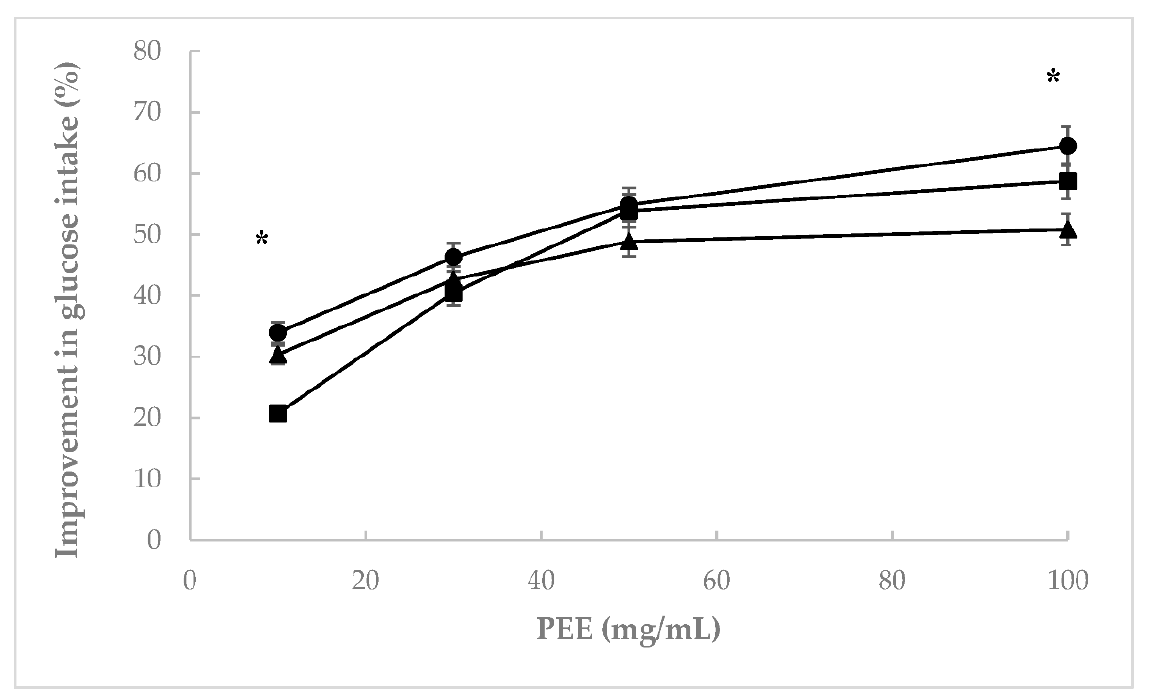
Figure 4. Effect of mistol extracts (PEE) on glucose consumption by S. cerevisiae : Skin ( ■ ), pulp ( ● ), and seed ( ▲ ) PEE. Results are expressed as the mean of three independent tests with SEM. The symbol * at a given extract concentration indicates significant differences ( p ≤ 0.05) between percentage of improvement in glucose intake by yeast cells between the three parts of mistol fruits, according to Tukey’s test .